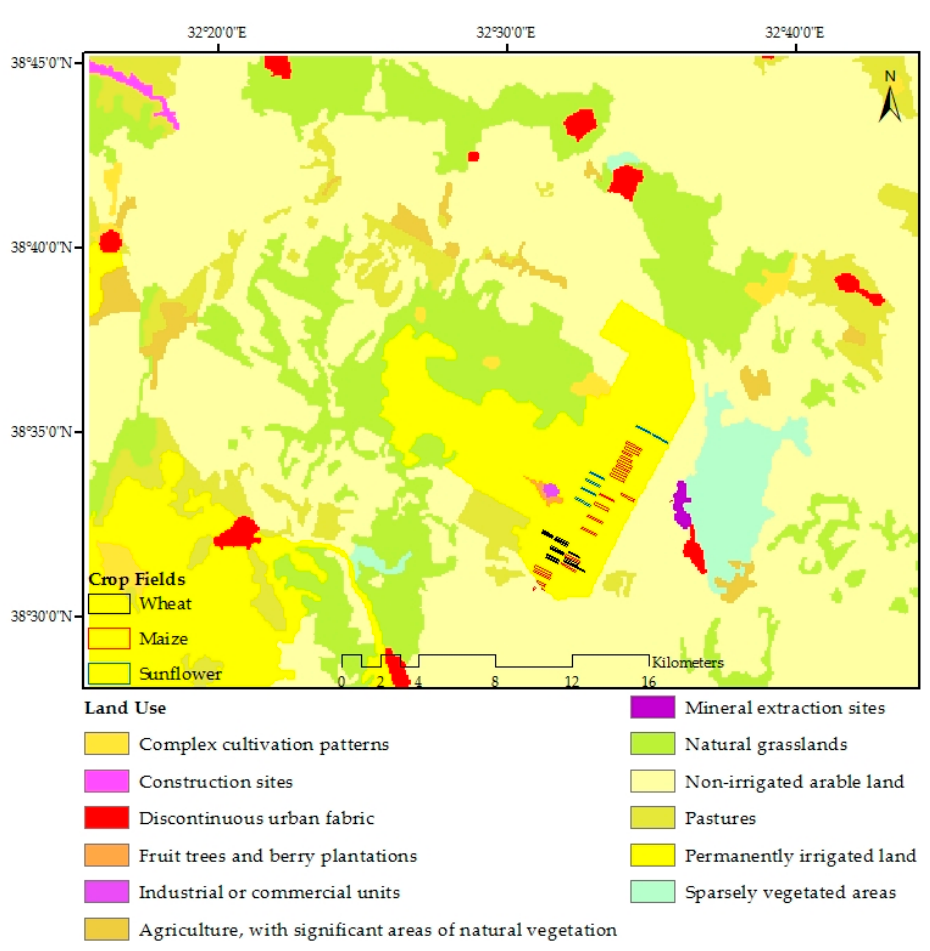
Figure 3. Land use map of the study area (Source: Copernicus Land Monitoring Service [19]).